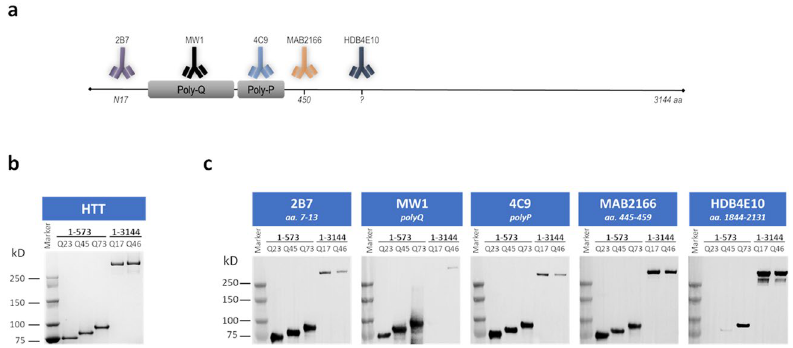
Figure 1. Reagent qualification. ( a ) Schematic of the HTT protein and the location of the epitope of each antibody used in the present work (the protein length is not properly scaled). ( b ) Coomassie staining of the five standard protein used in the present work (left to right for each panel: N573 Q22, N573 Q45, N573 Q72, FL Q17, FL Q46). ( c ) Western blots of the five standard proteins (left to right for each panel: N573 Q22, N573 Q45, N573 Q72, FL Q17, FL Q46) stained with the five antibodies used in the present work. Figure S-1 shown the full length gels and the high exposure full length Western